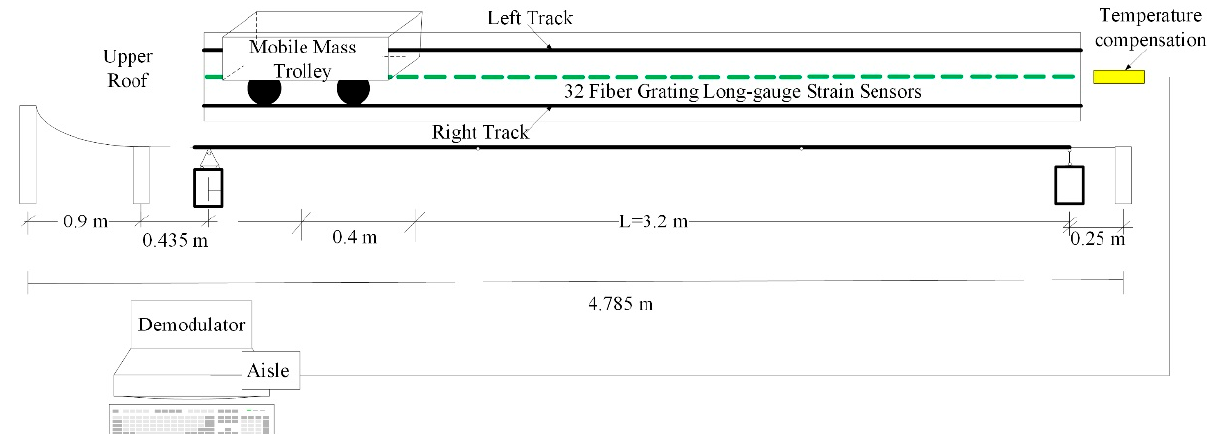
Figure 4. Vehicle–bridge experimental model and sensor layout diagram.